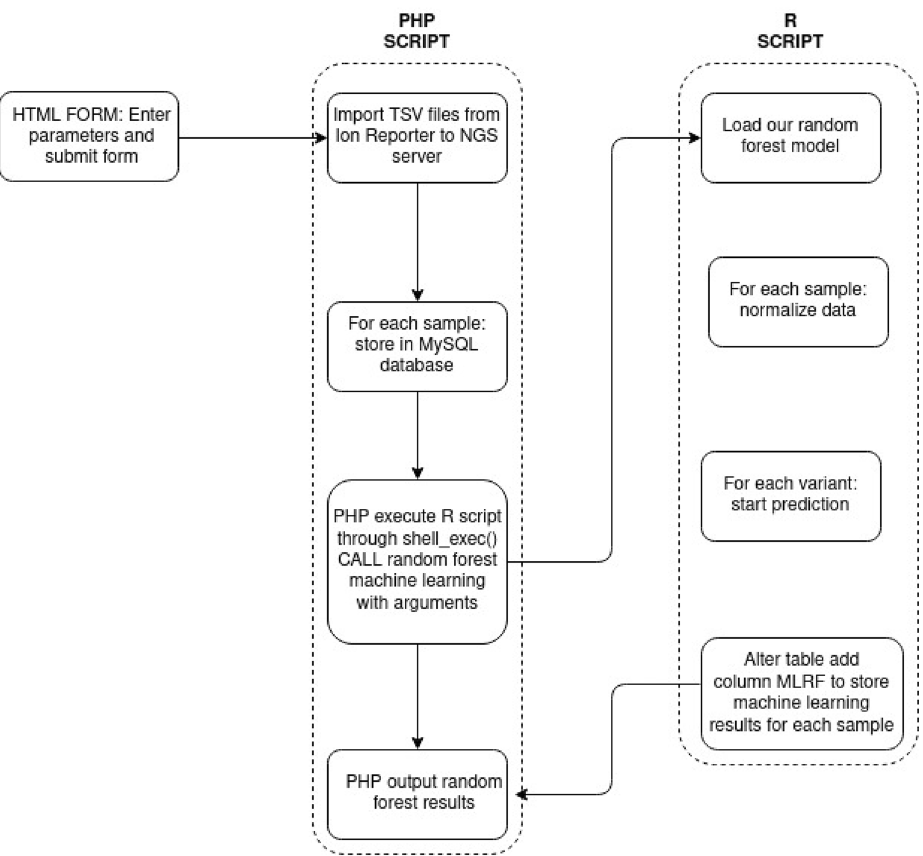
Figure 4. Machine learning data processing. It shows how data are imported and analyzed by random forest machine learning. This architecture was implemented in our laboratory for each NGS